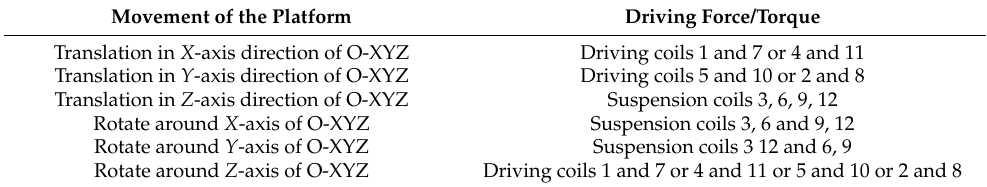
Table 1. The relationship between the motion of the platform and the driving/suspension coil. Movement of the Platform